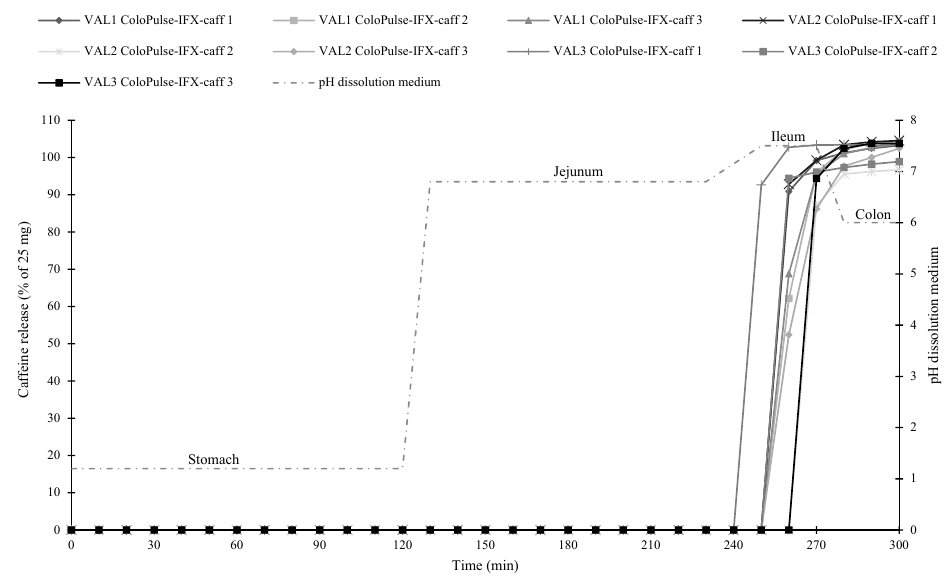
Figure 6. The results of the gastrointestinal simulation system (GISS) of the three validation batches (VAL1-3). Caffeine (25 mg) was added to ColoPulse-IFX (ColoPulse-IFX-caff) to investigate the in vitro coating performance with UV-VIS spectroscopy (see also Section 2.14).